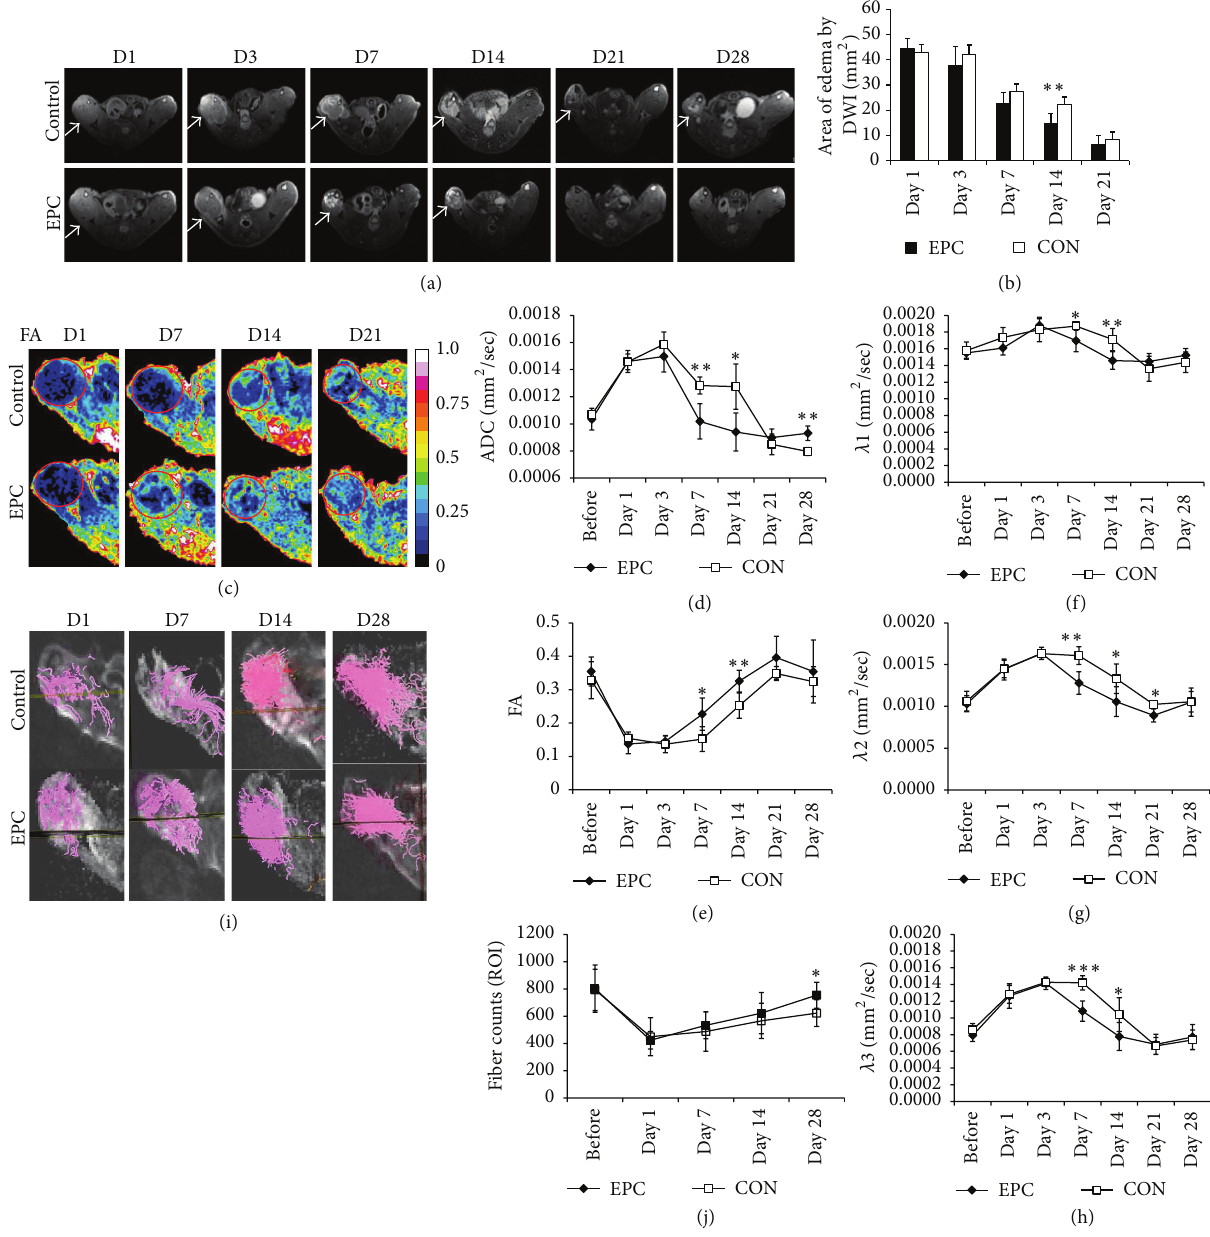
Figure 5: In vivo ischemic muscle regeneration effect of EPCs by MR-DTI. (a): Representative DWI at 1, 3, 7, 21, and 28 days in ischemic gastrocnemius muscles in control media injected and EPCs transplanted mice (high signal in DWI indicated diffusion restriction, white arrowhead). A bar graph (b) showed that administration of EPCs significantly reduced the region of edema at day 14 after EPCs transplantation. (c) Representative pixel maps of FA at 1, 7, 14, and 21 days (red circle). Line graphs showed that ADC (d), FA (e), 𝜆 1 (f), 𝜆 2 (g), and 𝜆 3 (h) of EPCs transplantation improved better than that of control group at days 7 and 14 after ischemia. (i) Representative fiber tracking maps at 1, 3, 7, and 28 days. The fiber counts (j) in ischemic gastrocnemius muscles at day 28 after EPCs transplantation were more than those of control group. ∗ 𝑃 < 0.05 , ∗∗ 𝑃 < 0.01 , and ∗∗∗ 𝑃 < 0.001